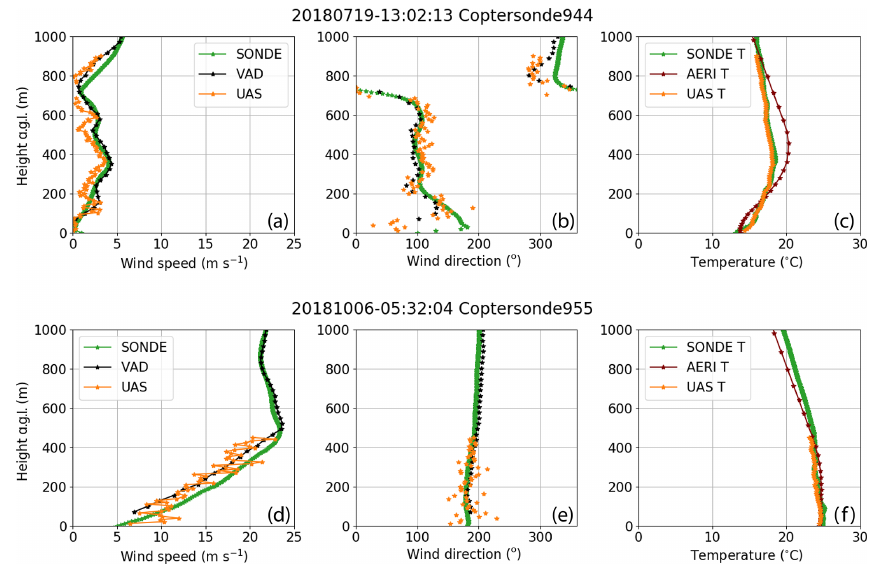
Figure 12. Profiles of wind speed (ms − 1 , a, d ), wind direction (degrees, b, e ), and temperature ( ◦ C, c, d ). Data from LAPSE-RATE (a–c) are from 19 June 2018 at 13:02UTC, while data from Flux Capacitor (d–e) are from 6 October 2018 at